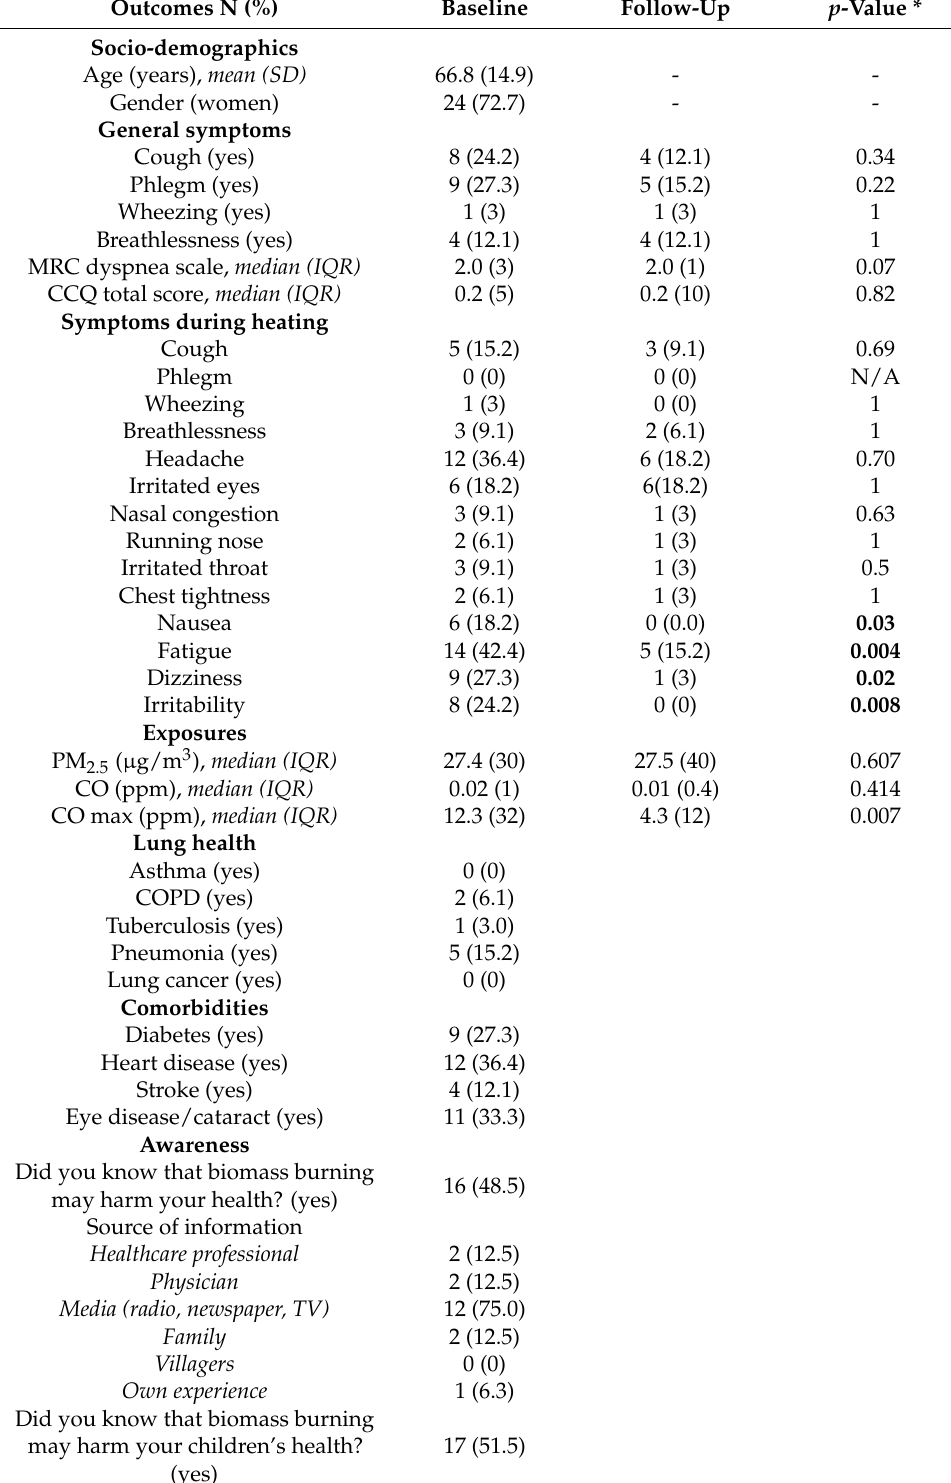
Table 2. Respiratory health-related outcomes in combination with exposure data of residents with paired data in rural households using biomass fuels in Crete, Greece (N =